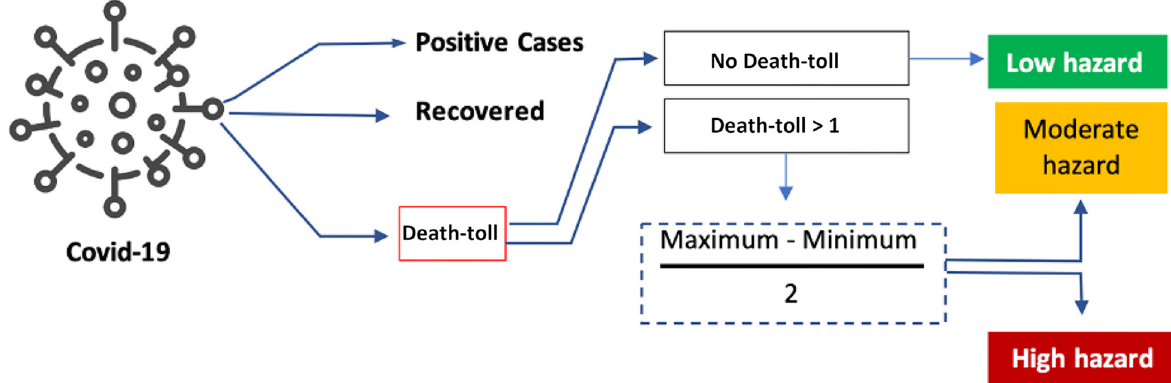
Fig. 3. Fig. 3. Covid-19 hazard Table 2. The Gerbangkertosusila-Bama or Greater Surabaya administrative area (BPS-Statistic of Jawa Timur,